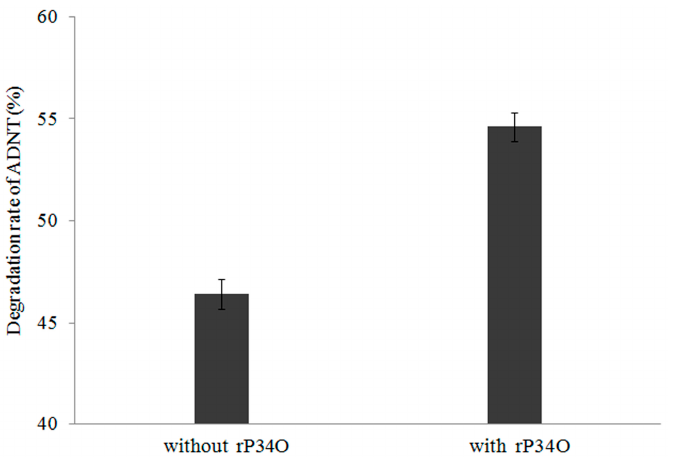
Figure 6. Degradation rates of ADNT by Buttiauxella sp. S19-1 with or without rP34O. Data are presented as mean of N = 4, ⎯ x ± SD. Statistical significance is denoted as p < 0.05 using SPSS.